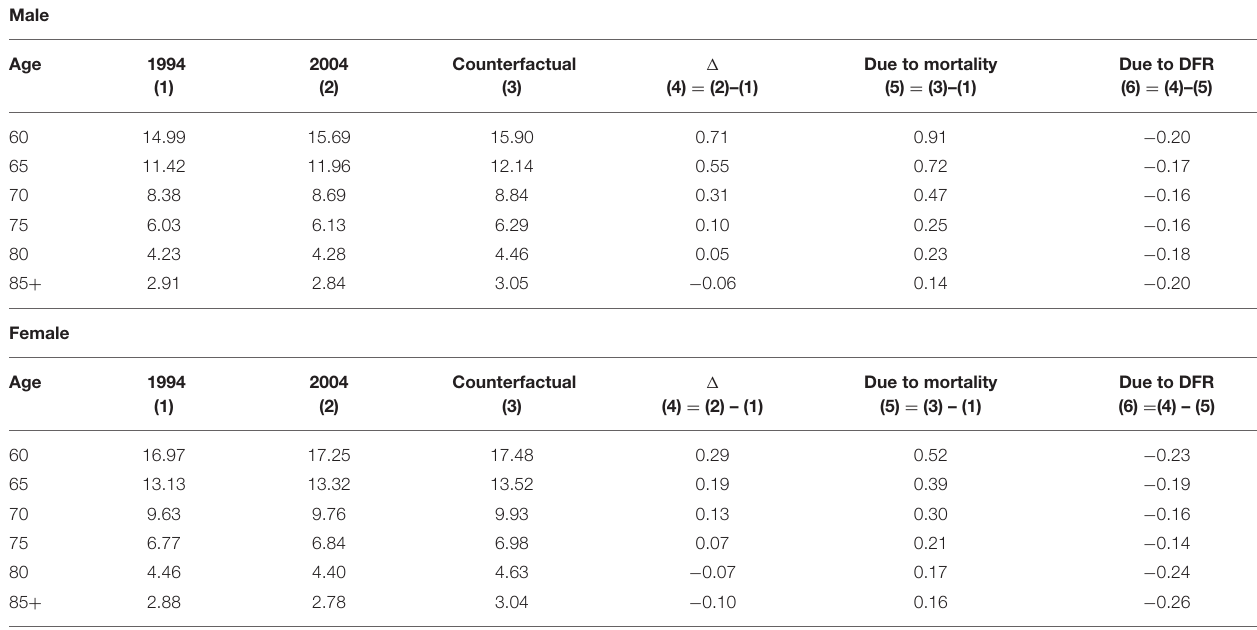
TABLE 2 | The effect of changes of the mortality and disability-free rate of the elderly on HLE from 1994 to